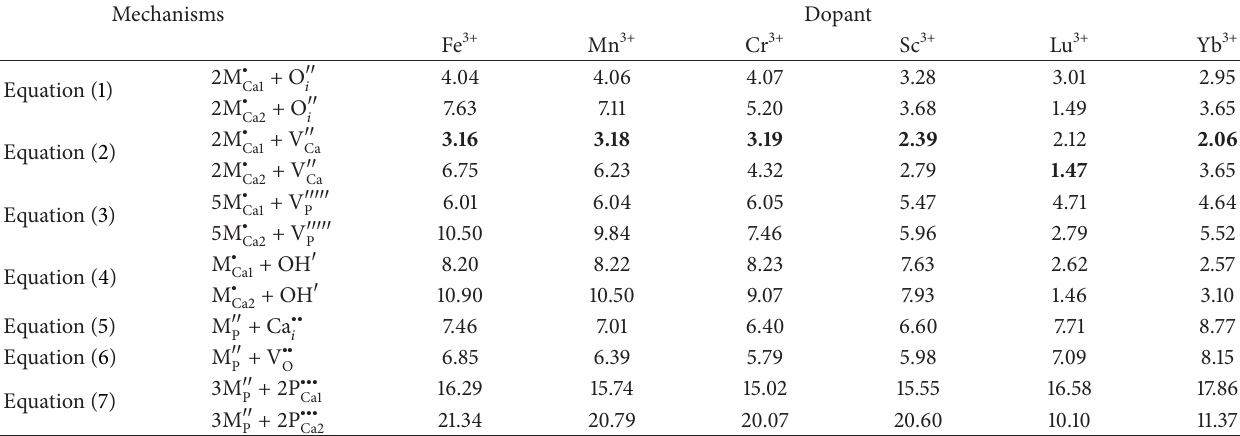
Table 5: Solution energies (eV) for substitution of the transition metals (M 3+ = Fe, Mn, Cr, and Sc) and rare earth (M 3+ = Lu and Yb) ions in HAP.